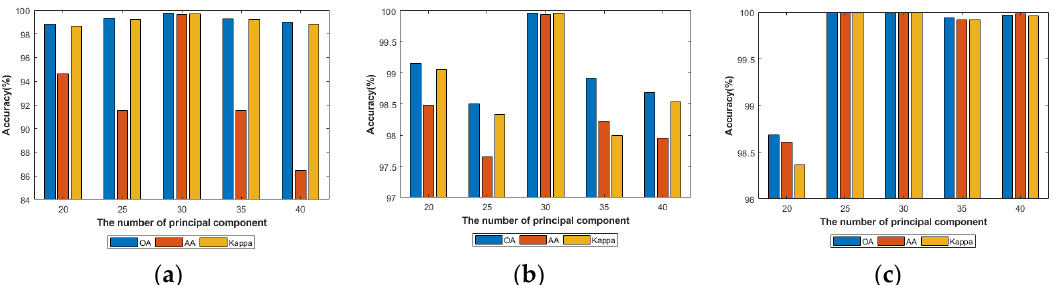
Figure 11. The influence of the number of principal components. ( a – c ) represent the influence of the number of principal components on IN, KSC and SA respectively.